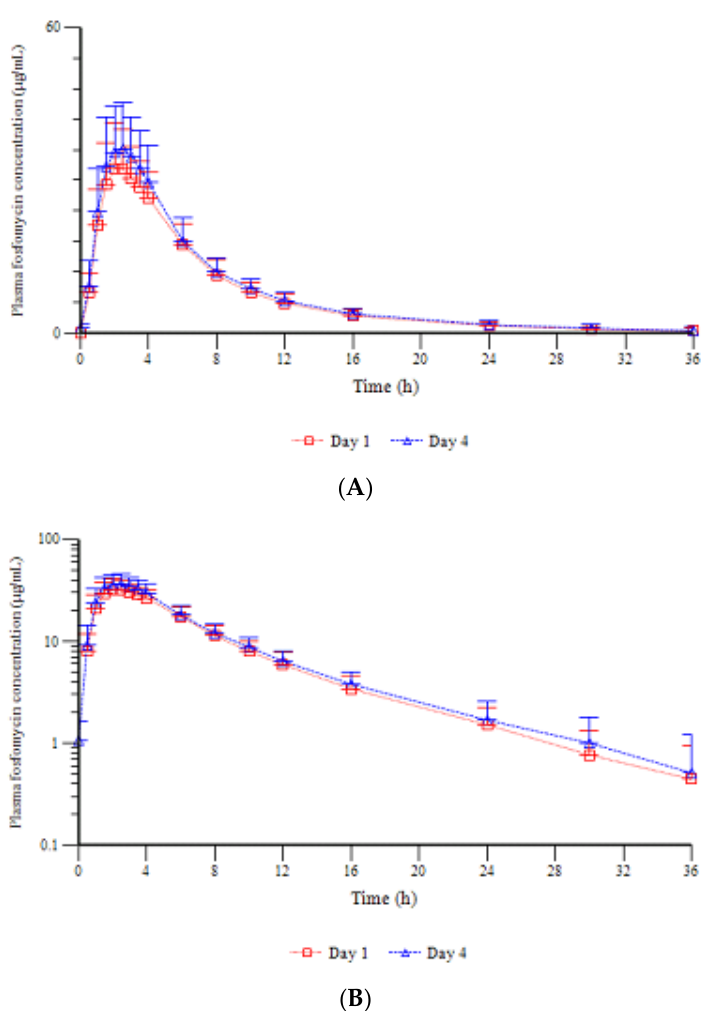
Figure 2. Mean (+SD) plasma fosfomycin ( µ g/mL) vs. time profiles after single and two consecutive doses of fosfomycin trometamol. Linear scale ( A ) and semilogarithmic scale ( B ). On Day 1, the fosfomycin levels rapidly increased in the plasma after the single dose. The highest observed concentration was 32.271 ± 7.634 µg/mL, attained on average 2.5 h postdose. After the peak, fosfomycin decreased in the plasma until 36 h postdose, when it was below the quantification limit in half of the subjects.